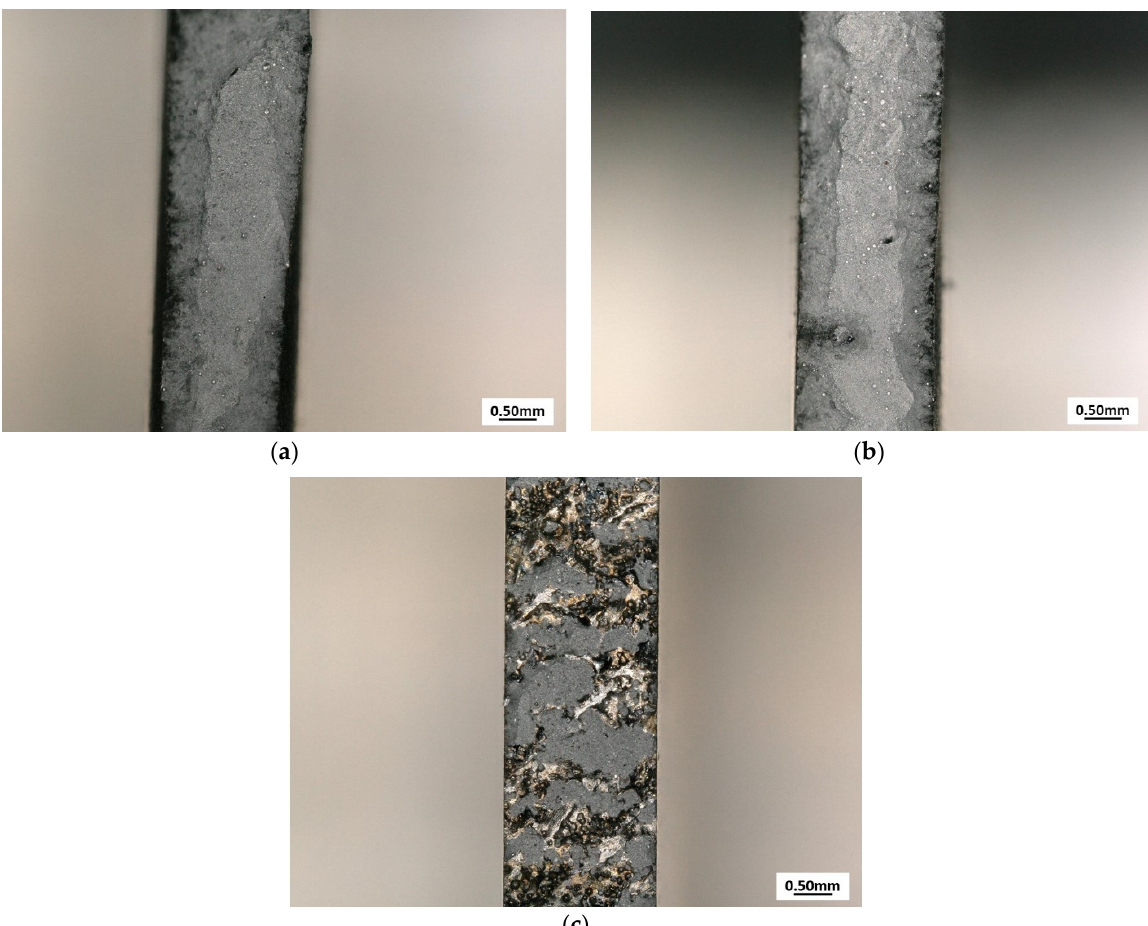
Figure 10. Fractures of ( a ) sample A (layer thickness—0.5 mm), ( b ) sample B (layer thickness—0.75 mm), ( c ) sample C (layer thickness—1 mm).